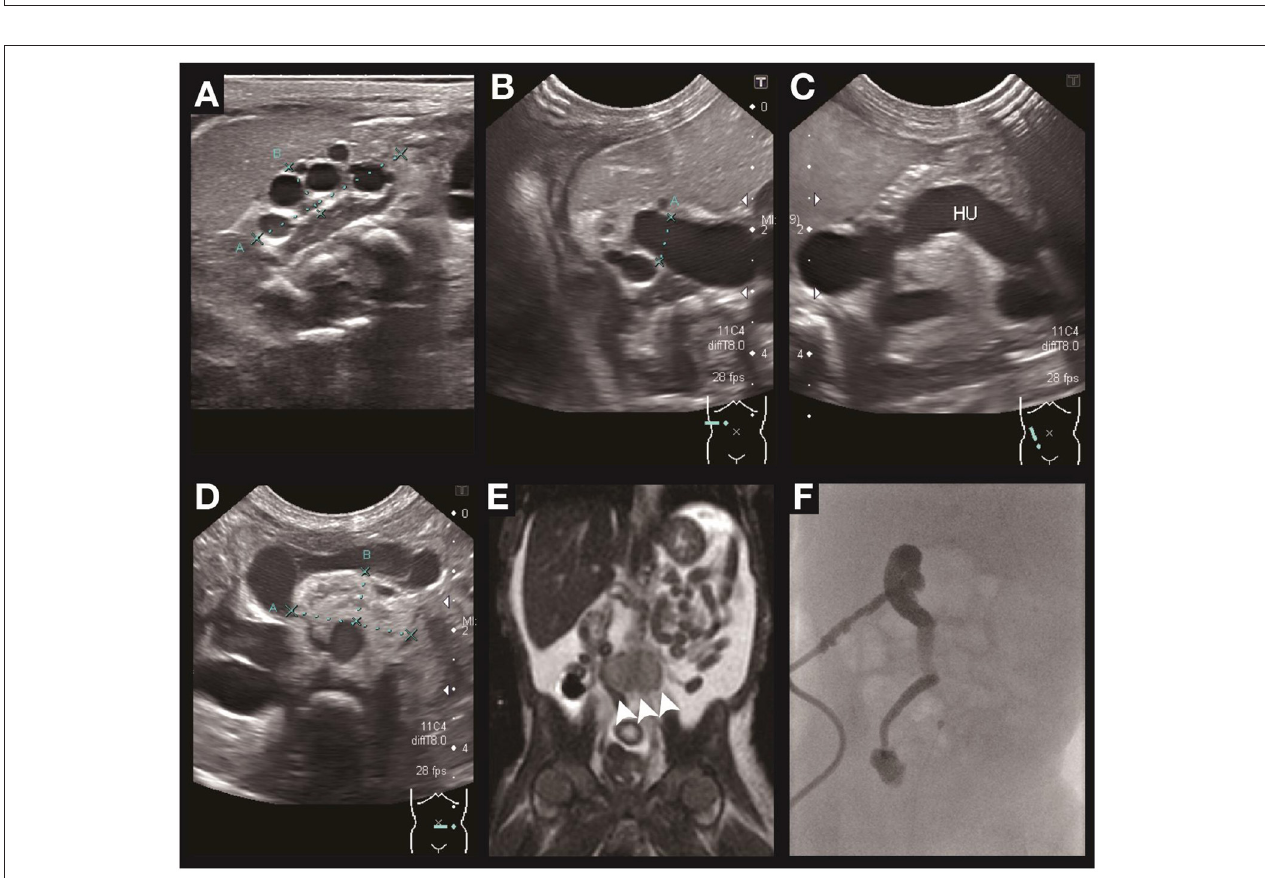
FIGURE 2 | Renal ultrasound, MRI, and antegrade pyelography of case B. Ultrasonography of the urinary systems depicts small size of the right kidney with dysplasia and multiple cysts formation (A) , right hydronephrosis (B) , right hydroureter (C) , and left ectopic kidney with dysplasia and hypoplasia. (D) MRI of the abdomen (E) confirmed the ectopic left kidney anterior to the aortic bifurcation (arrowhead). Antegrade pyelography (F) depicts high grade obstruction at the distal third of the right ureter with contrast medium not passing into the urinary